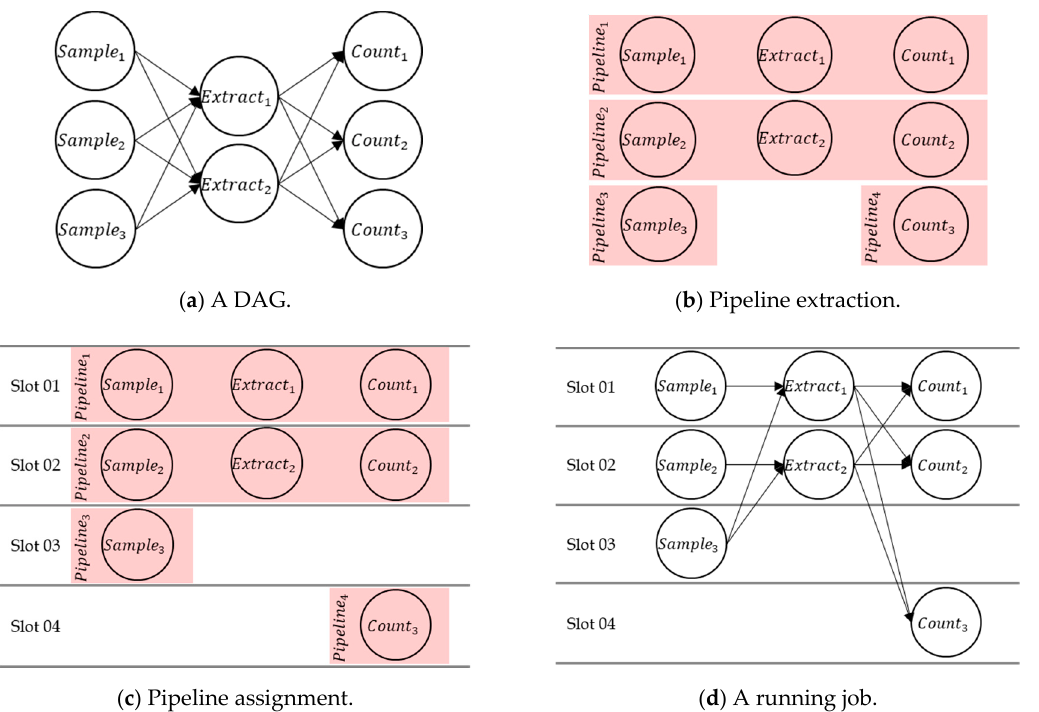
Figure 4. Example of pipeline extraction and pipeline assignment in Locality/Fairness-aware (L/F) job scheduler.